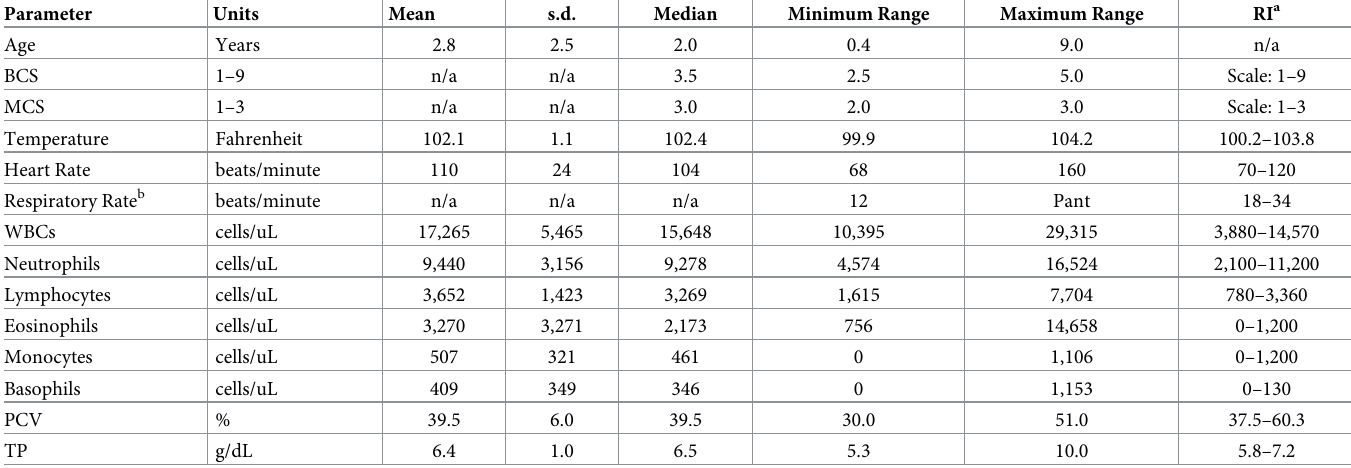
Table 1. Selected physical exam findings from Waiwai domestic dogs (n = 20 dogs) and results from differential white blood cell counts, packed cell volume (PCV), and total protein (TP). Reference intervals for blood cell parameters from the UMN-CVM VMC Clinical Pathology Laboratory were included for comparison.